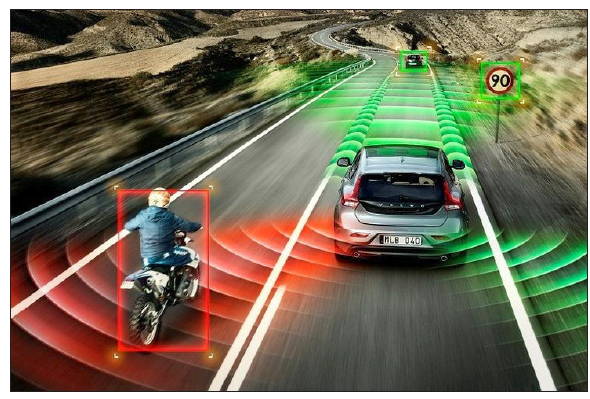
Figure 7: Illustration of a self-driving car. 19 Green indicates safe zones picked up by the sensors of the self-driving car and red indi- cates danger zones.